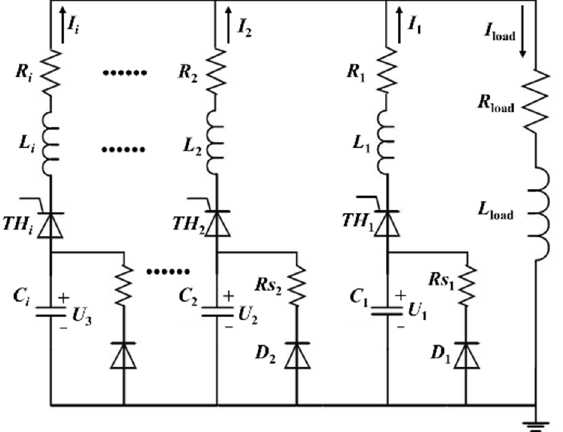
Figure 2. The excitation circuit topology of the railgun.